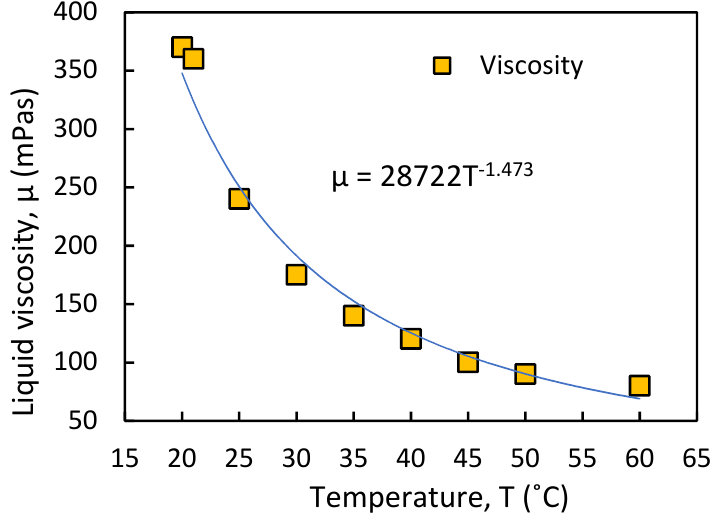
the study. Figure 3 is a chart showing shows liquid viscosity as a function of temperature. By manipulating the liquid temperature, the desired liquid viscosity was obtained for the study. Generally, a decrease in temperature yielding a corresponding increase in liquid viscosity was observed. Properties of fluids used in the study are presented in Table 2.